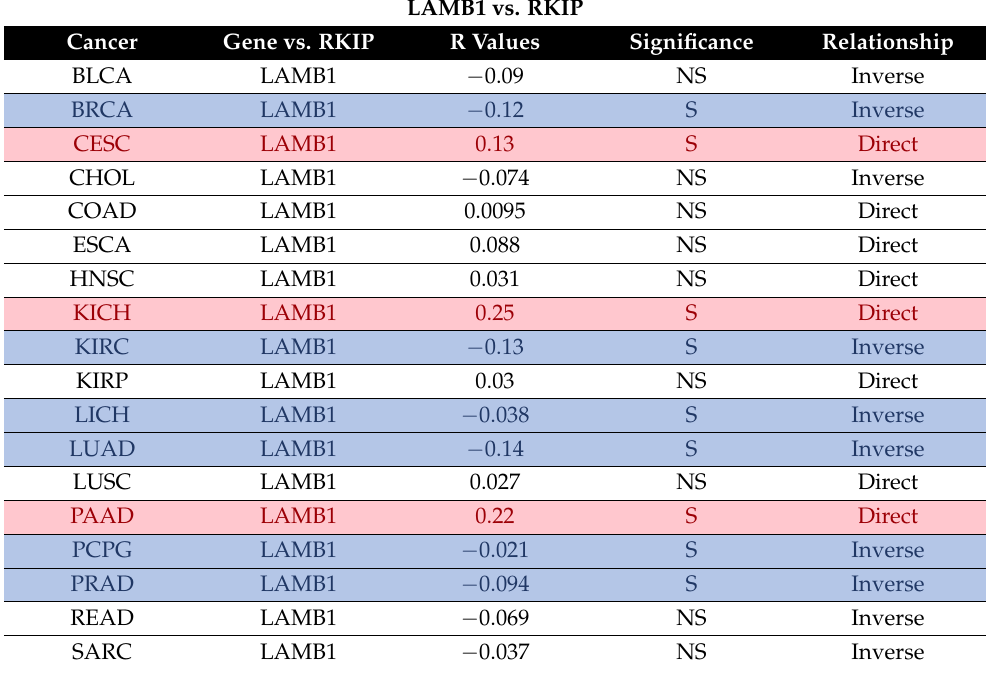
Blue: Significant Inverse Relationship; Red: Significant Direct Relationship. Table 7. RKIP vs. LAMB1. A bioinformatic analysis was performed across 23 different cancer types comparing the presence of RKIP against VIM. From this data, a p -value and an R value were determined for each of the cancer types. The table above organized the bioinformatic data. For each cancer type, the R value was reported in the third column. Significance was determined based on the p -value, with a p -value less than 0.05 indicating a significant value. The relationship between RKIP and LAMB1 was determined through the sign of the R value. A negative R value indicated an inverse relationship while a positive R value indicated a direct relationship. The rows highlighted in blue indicate a significant, inverse relationship between RKIP and LAMB1. The rows highlighted in red indicate a significant, direct relationship between RKIP and